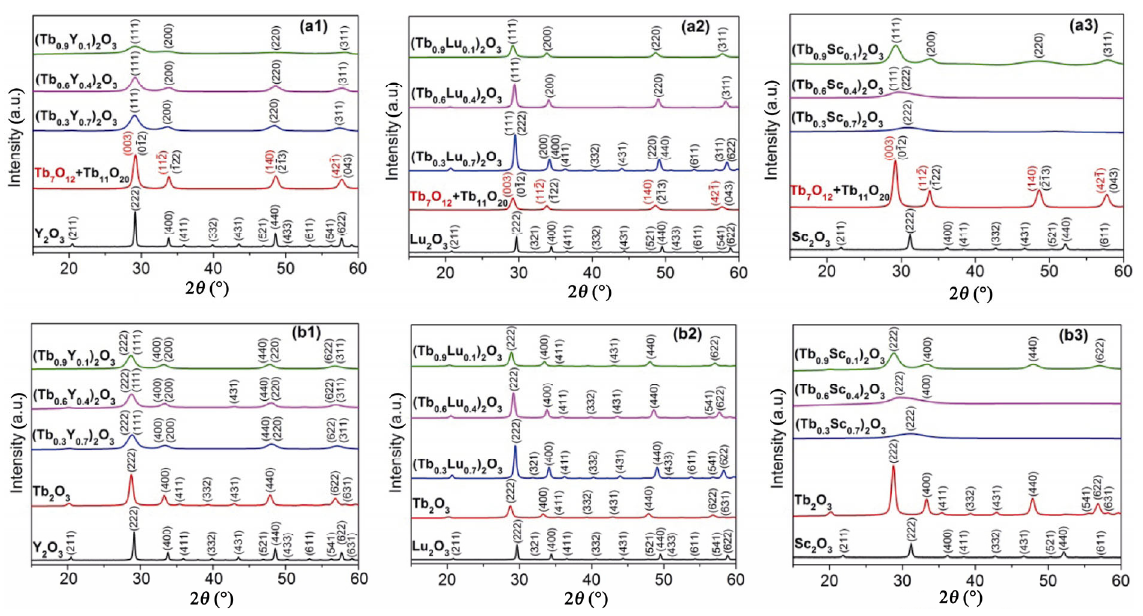
Fig. 2 XRD patterns of the powders (a1–a3) after the SHS and (b1–b3) after reducing in isopropyl alcohol